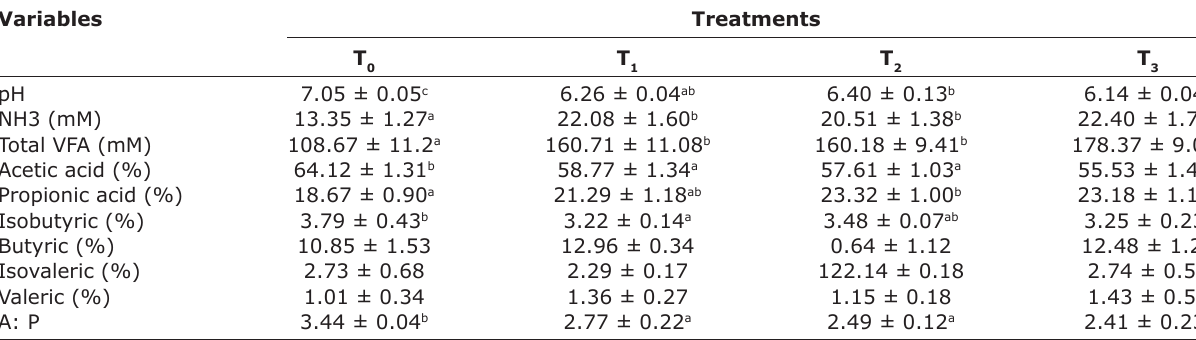
Table-2: Fermentation products from in vitro rumen fermentation supplemented with probiotic.